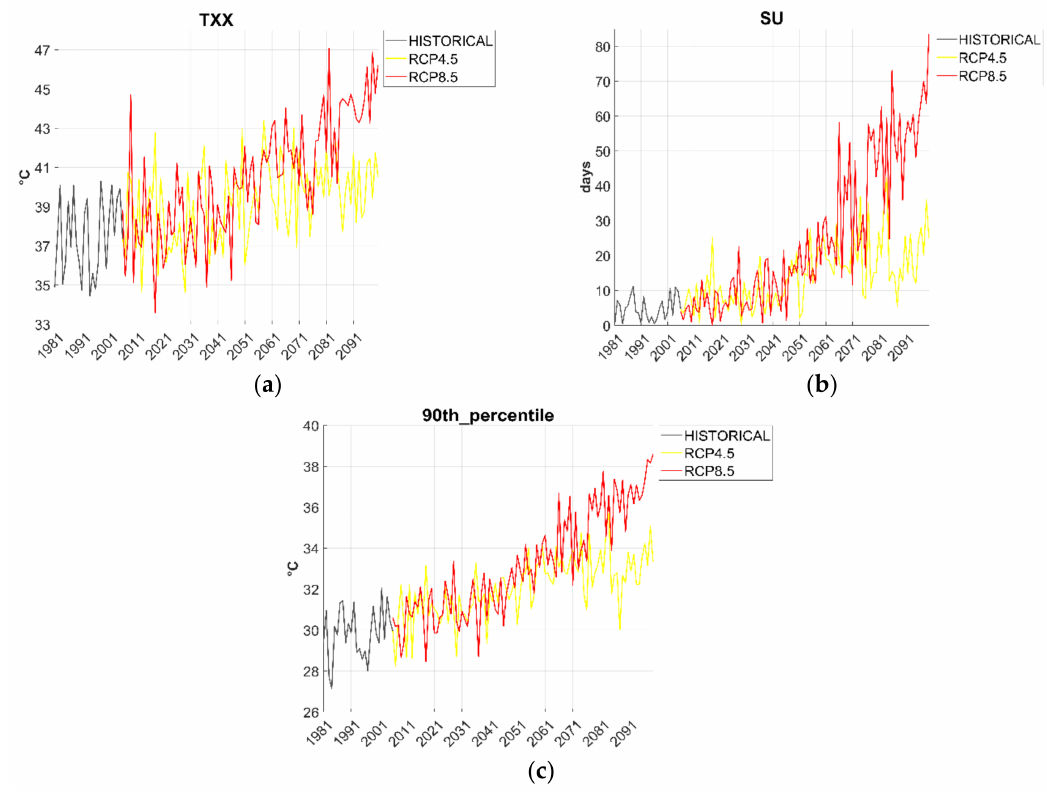
Figure 5. Time series of ( a ) TXx, ( b ) SU and ( c ) 90p-Tmax under IPCC RCP4.5 and RCP8.5 scenarios.